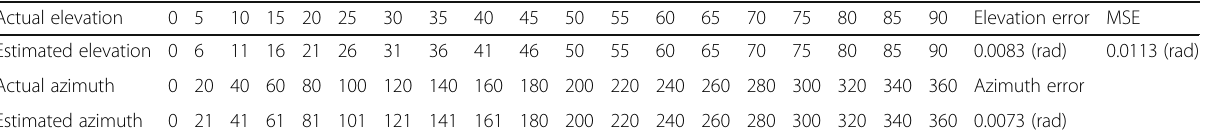
Table 4 Tracking results with an ideal